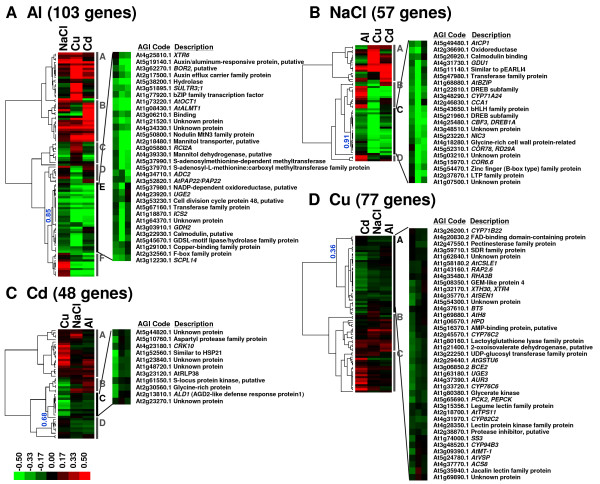
Hierarchical cluster analyses within gene groups uniquely induced by rhizotoxic ion treatments (I90). Gene groups for Al ion (A), NaCl (B), Cd ion (C) and Cu ion (D) were selected by comparative microarray analysis (Figure 3) and were separately analyzed with a cluster program (see Methods) using the ratio of fold change (FC of other stressor/FC of particular stressor). The ratios of fold change of genes are indicated by color in each panel. Relatively specific clusters are enlarged and the names of genes are indicated for each treatment. Pearson's correlation coefficients were shown in each panel. The enlarged clusters are specific to the stressor than other sub-groups (see Additional file 5).